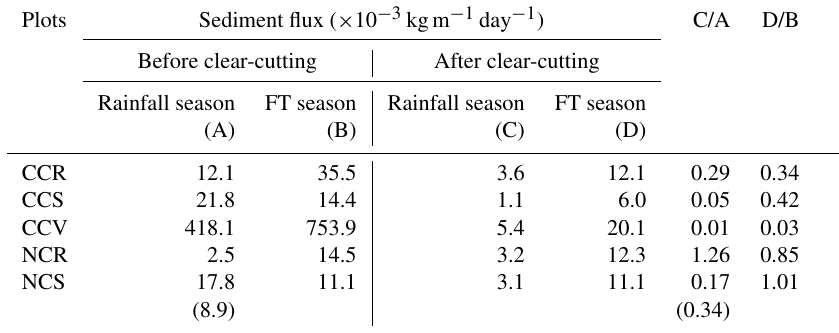
Table 4. Comparison of average sediment flux in rainfall and freeze–thaw (FT) seasons before and after forest harvesting. Values in paren- theses at plot NCS were calculated by excluding the weight of two exceptionally large boulders with weights of >1kg.